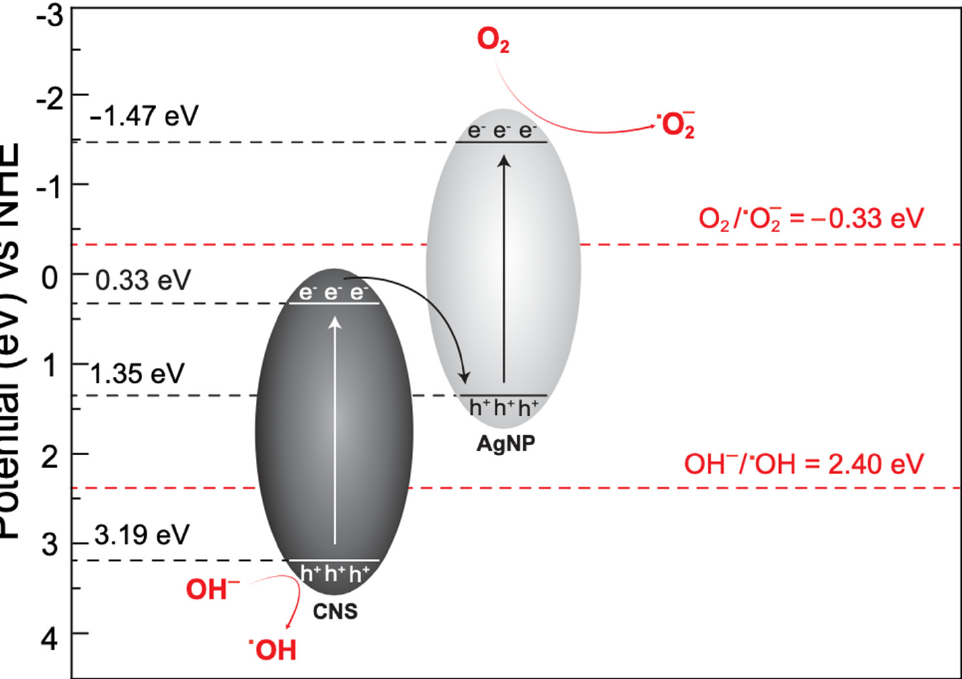
Figure 9. Proposed Z -scheme heterojunction mechanism of the photocatalytic action of the as-synthesized AgNP–CNS nanocomposite.